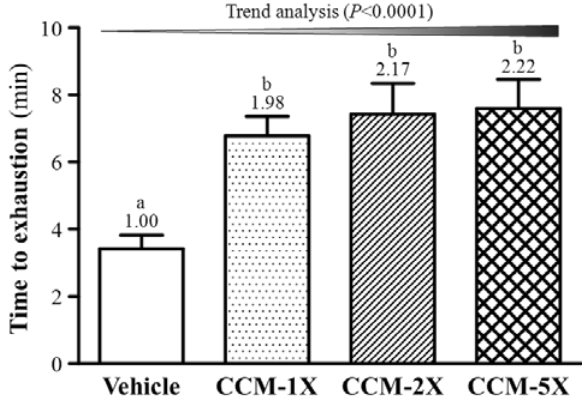
Figure 3. Effect of CCM supplementation on exhaustive swimming test. Data are mean ± SEM for n = 10 mice in each group. Different letters indicate significant difference at p < 0.05 by one-way